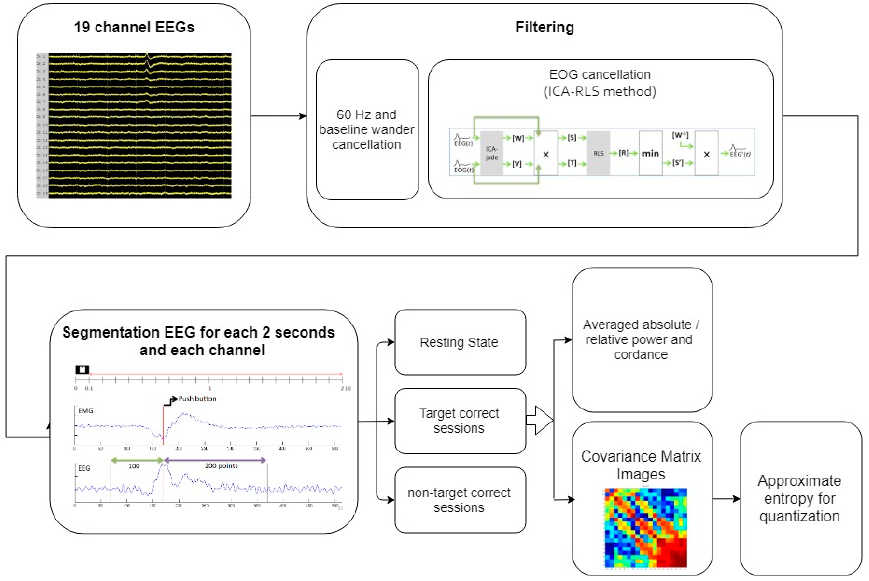
Figure 3. The system block diagram.